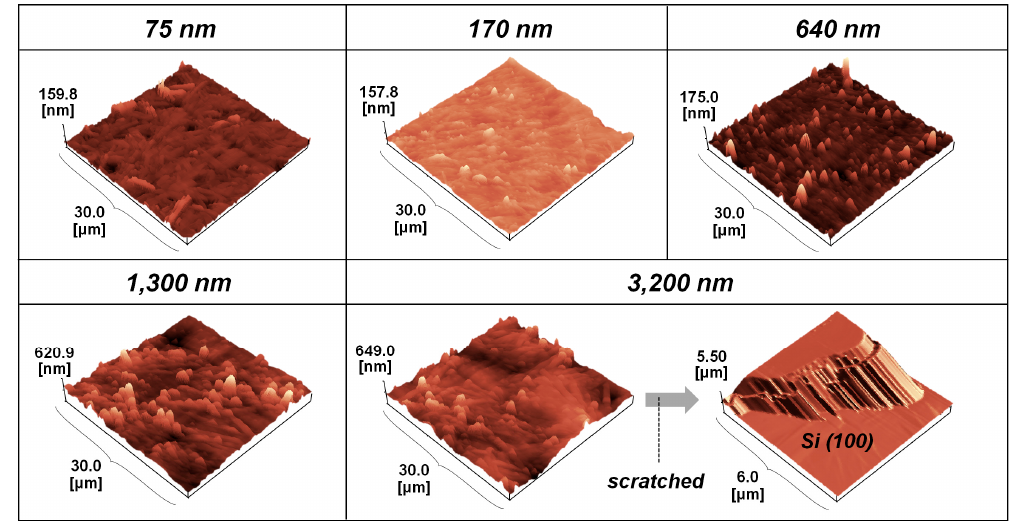
Figure 2. Atomic force microscopy (AFM) images of MO β Gal hemihydrate polycrystalline films with various thicknesses. For the 3200-nm-thick film, the scratched image is also depicted on the right.